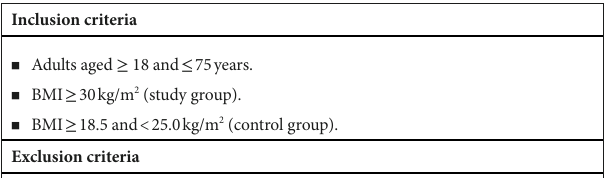
TABLE 1 Inclusion and exclusion criteria for the participants in both study